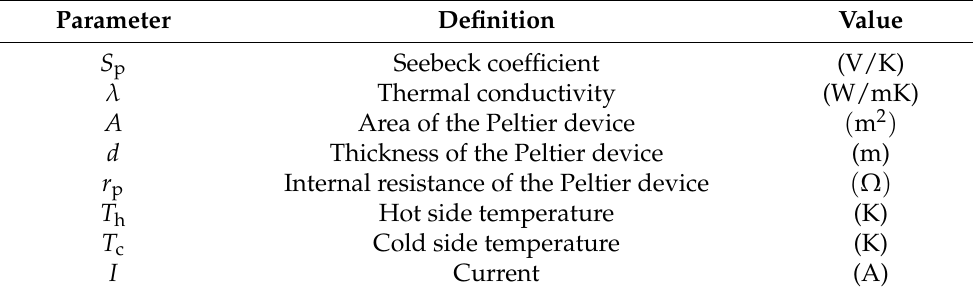
Figure 1. The structure of the Peltier device [20]. Table 1. Parameters of the Peltier